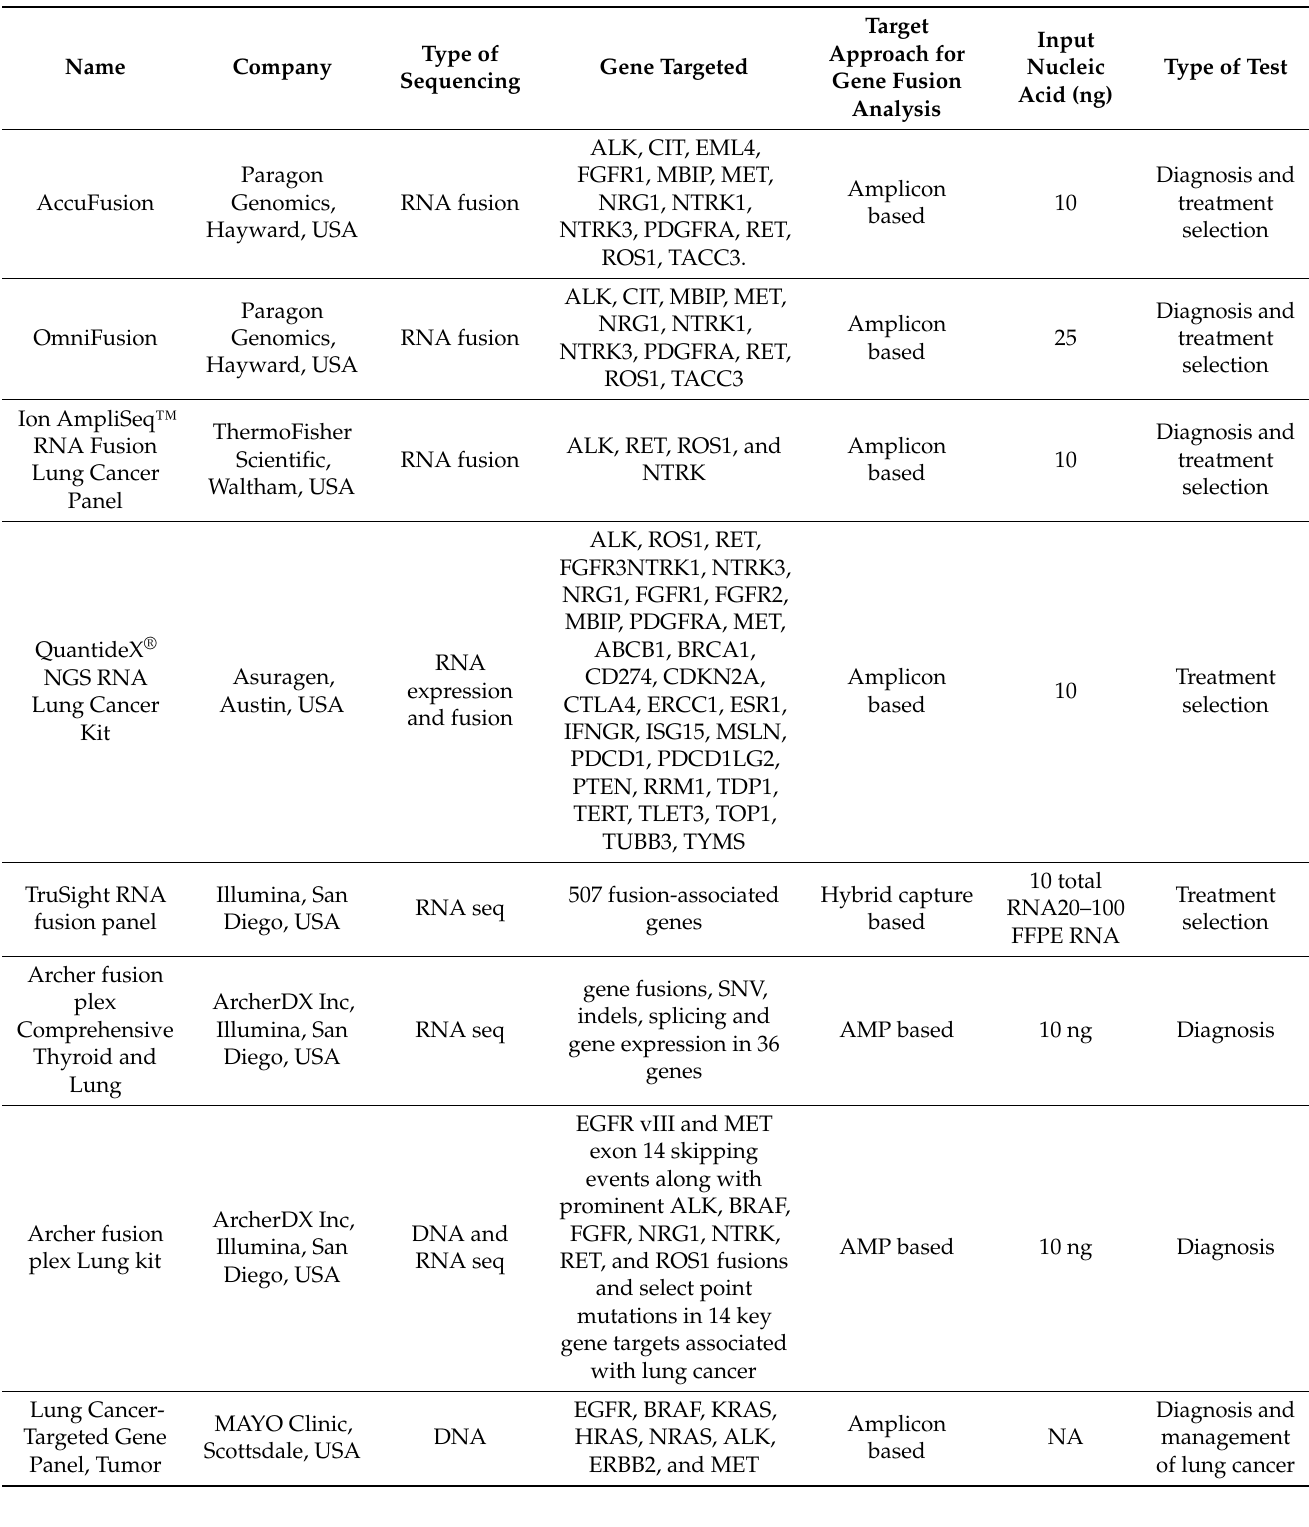
Table 2. Some commercially available NGS panels for lung cancer